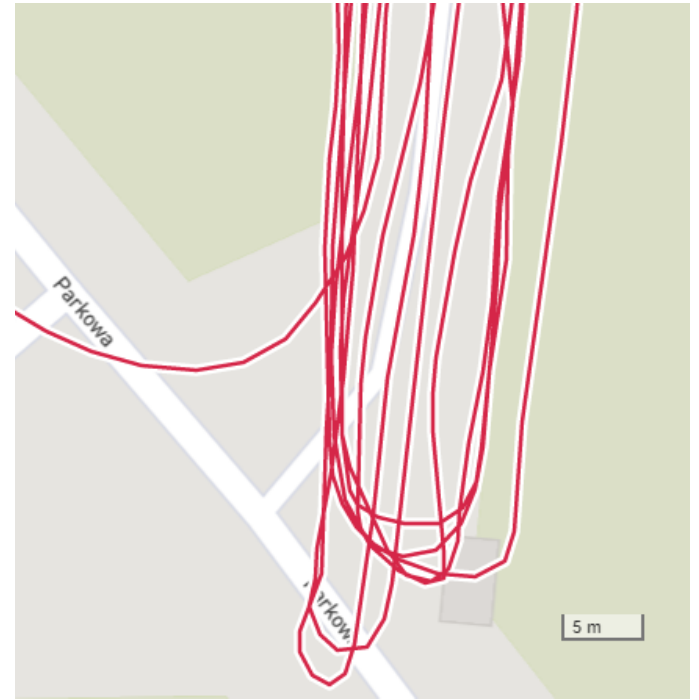
Figure 10. Turning around test without postprocessing (Samsung